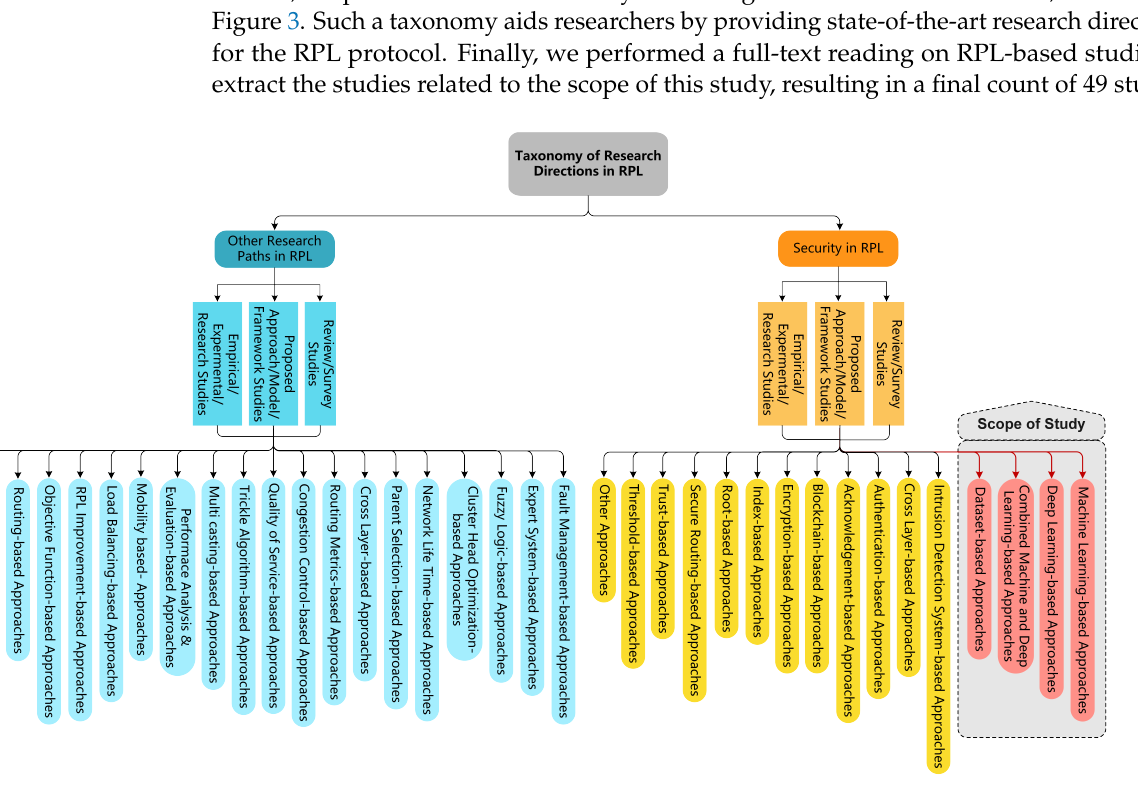
Figure 3. Taxonomy of existing research literature in